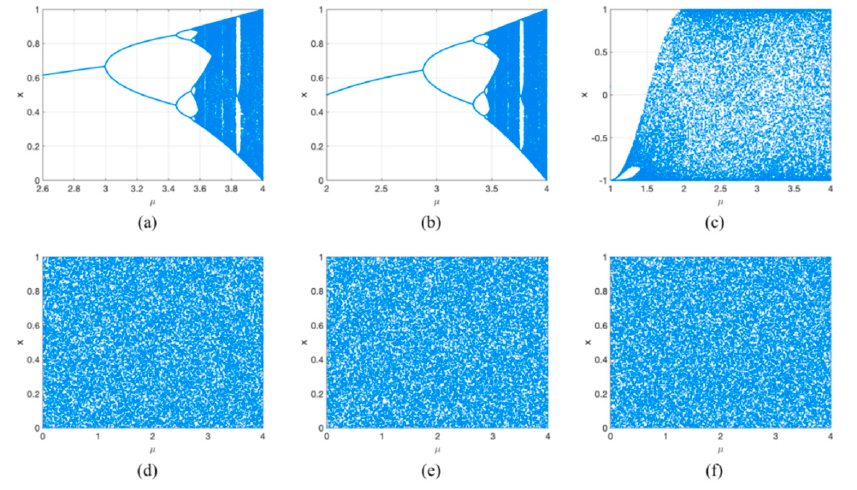
Figure 1. ( a – c ) The bifurcation diagrams of the Logistic map, Sine map and Chebyshev map. ( d –f) The bifurcation diagrams of the Logistic map, Sine map and Chebyshev map after using chaotic model.